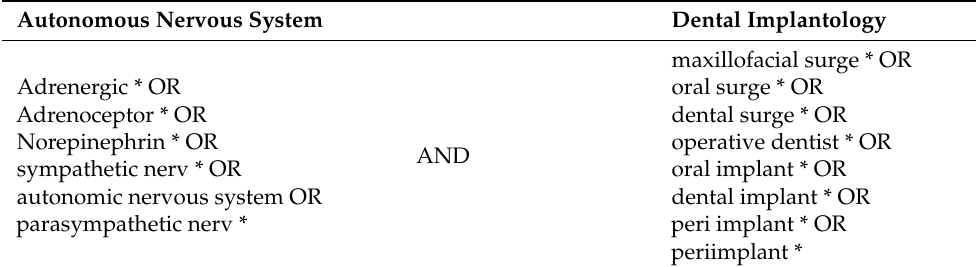
Table 1. Search terms. The asterisk (*) is the symbol for truncation. Autonomous Nervous